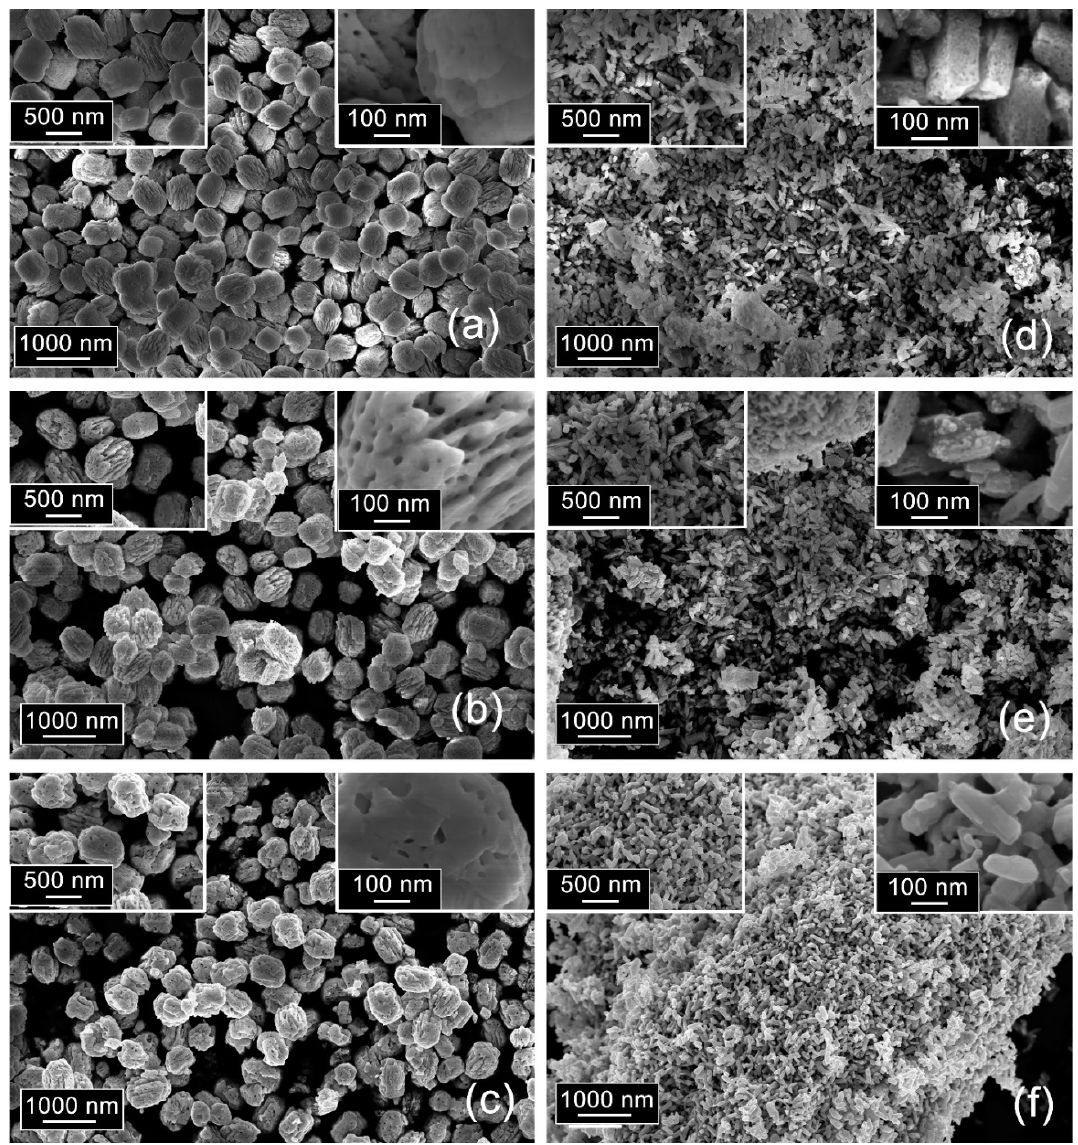
Figure 3. SEM images of Ga 2 O 3 samples, annealed at ( a ) 500, ( b ) 750 and ( c ) 1000 °C; Ga 2 O 3 (Sn) samples (x = 13 at.%), annealed at ( d ) 500, ( e ) 750 and ( f ) 1000 °C